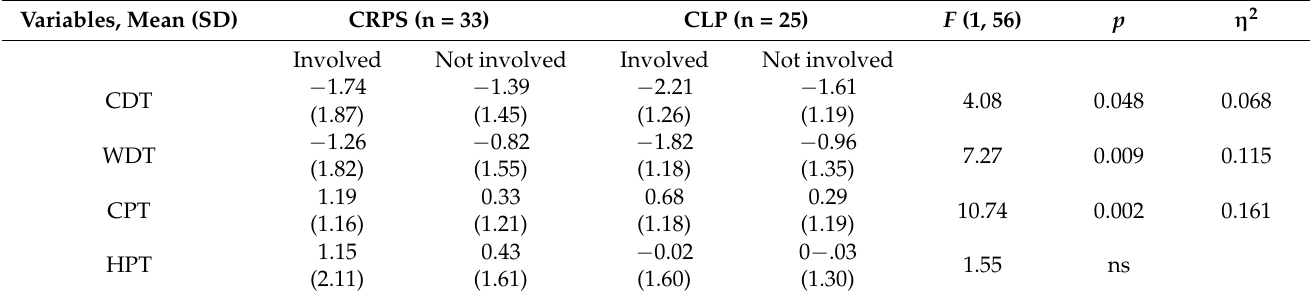
Table 2. The differences in thermal and pain threshold between limbs in CRPS and CLP groups.